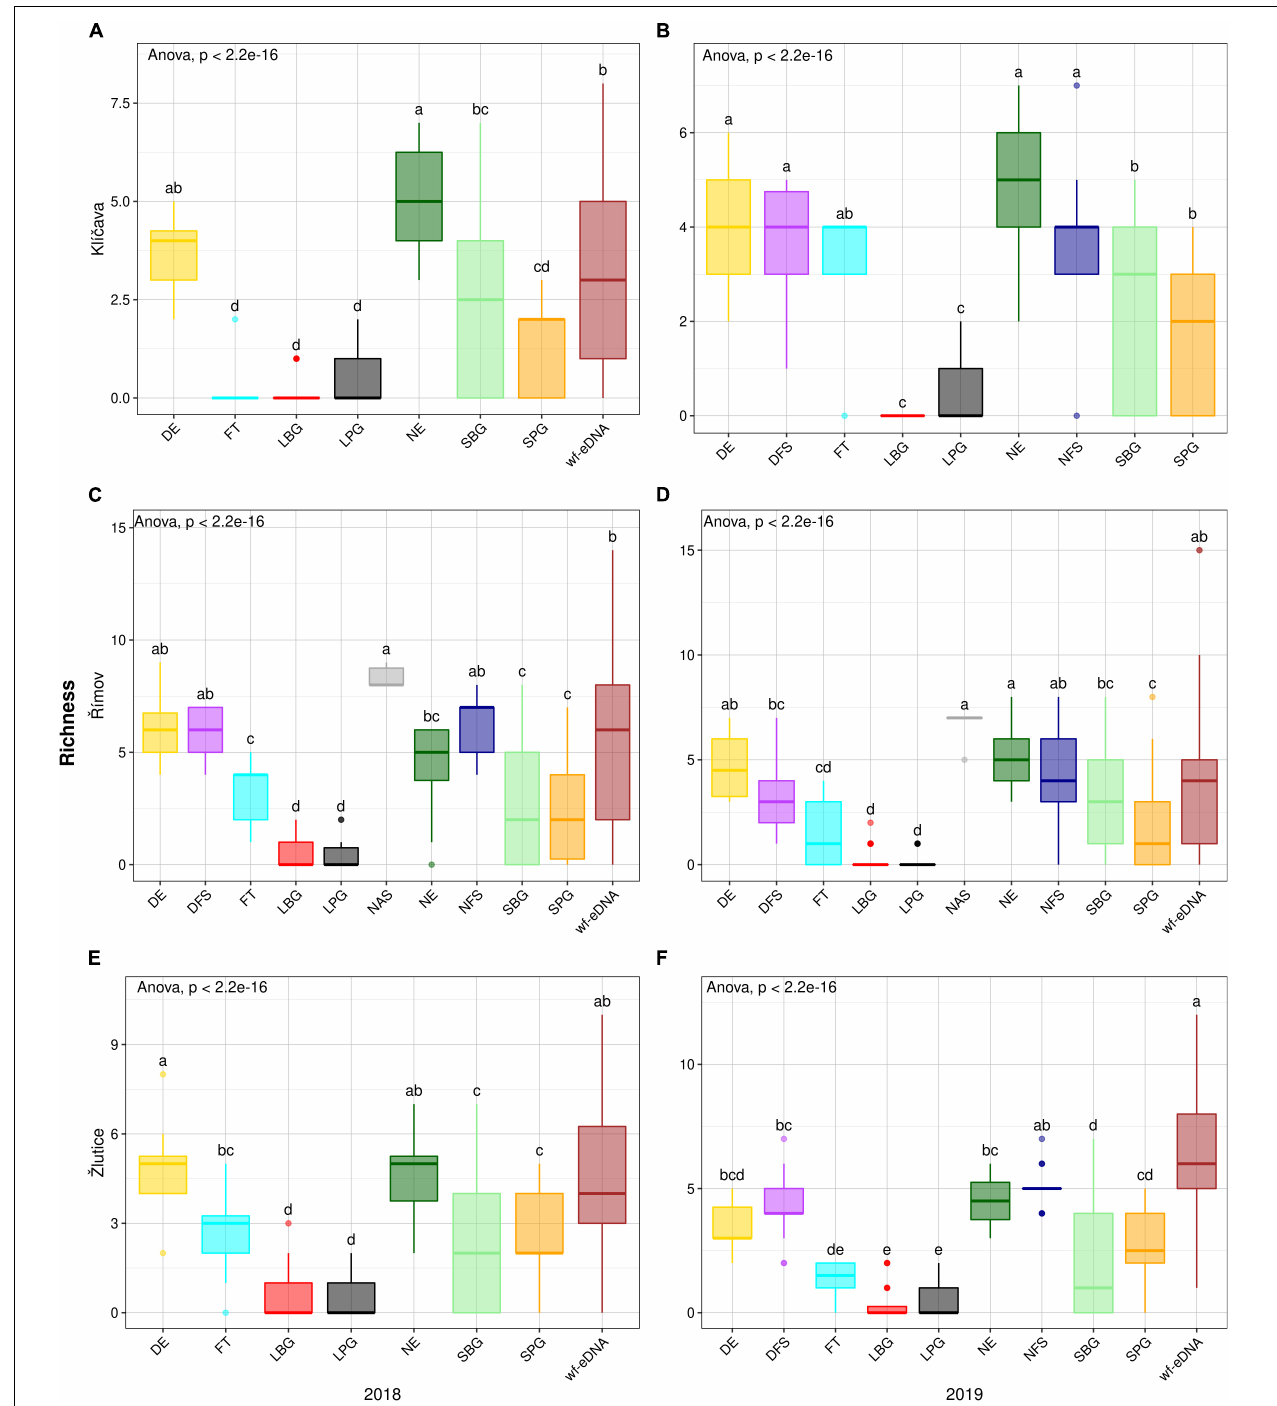
FIGURE 5 | Box plots comparison of alpha diversity (Richness) based on BPUE data in 2018 (left plots) and 2019 (right plots) between wf-eDNA assay and traditional sampling methods in Klíˇcava, ˇ Rímov and Žlutice reservoirs. Significant differences are indicated by different superscripts. The horizontal line inside the box indicates calculated median, box 1st and 3rd quartile, whiskers data range and dots outliers of Richness value. Traditional sampling methods are abbreviated as follow: DE = day electrofishing, NE = night electrofishing, SBG = standard benthic gillnets, SPG = standard pelagic gillnets, LBG = large mesh-size benthic gillnets, LPG = large mesh-size pelagic gillnets, NAS = night-time adult seining, DFS = day-time fry seining, NFS= night-time fry seining, FT = fry trawl and wf-eDNA = eDNA from water targeting fish.